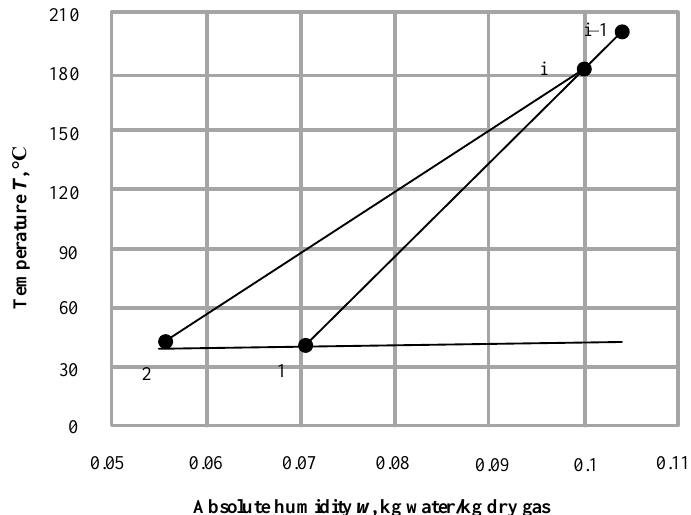
Fig. 3. Element of calculations scheme of direct contact heat